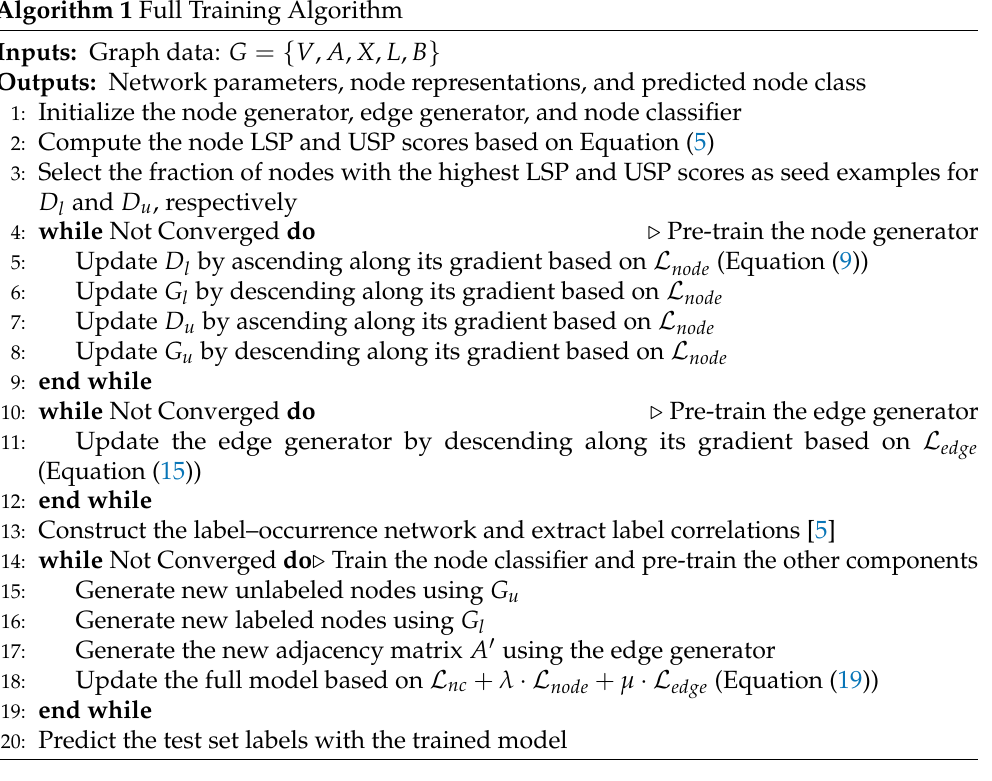
Algorithm 1 Full Training